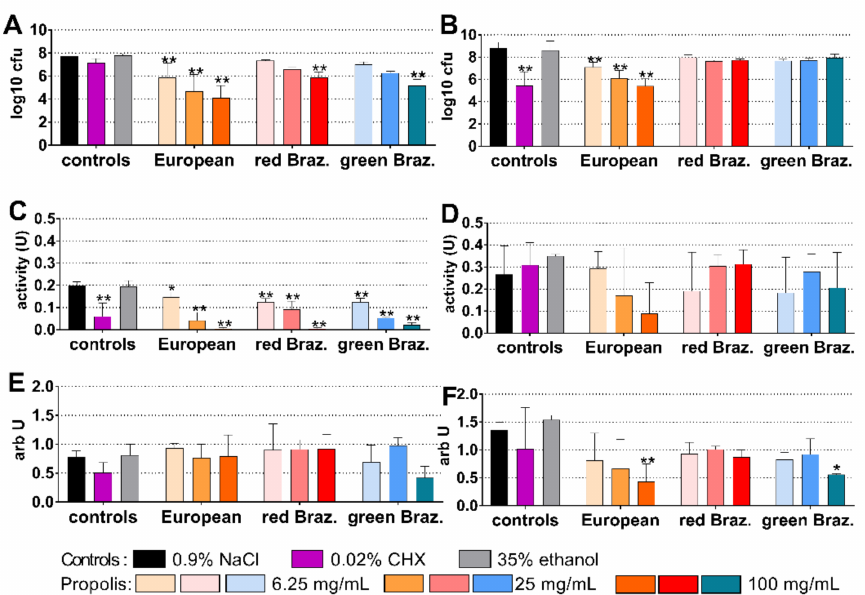
Figure 7. Activity of the different ethanolic extracts of propolis (European and red and green Brazilian (Braz.)) on colony forming units (cfu) ( A , B ), metabolic activity ( C , D ), and quantity ( E , F ) in a formed